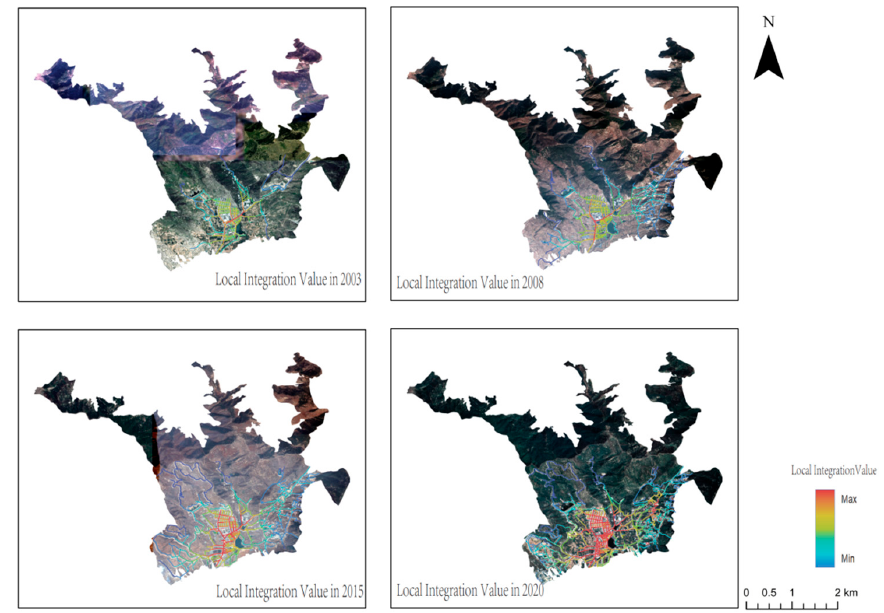
Figure 6. Evolution process of local integration in Matao Village.